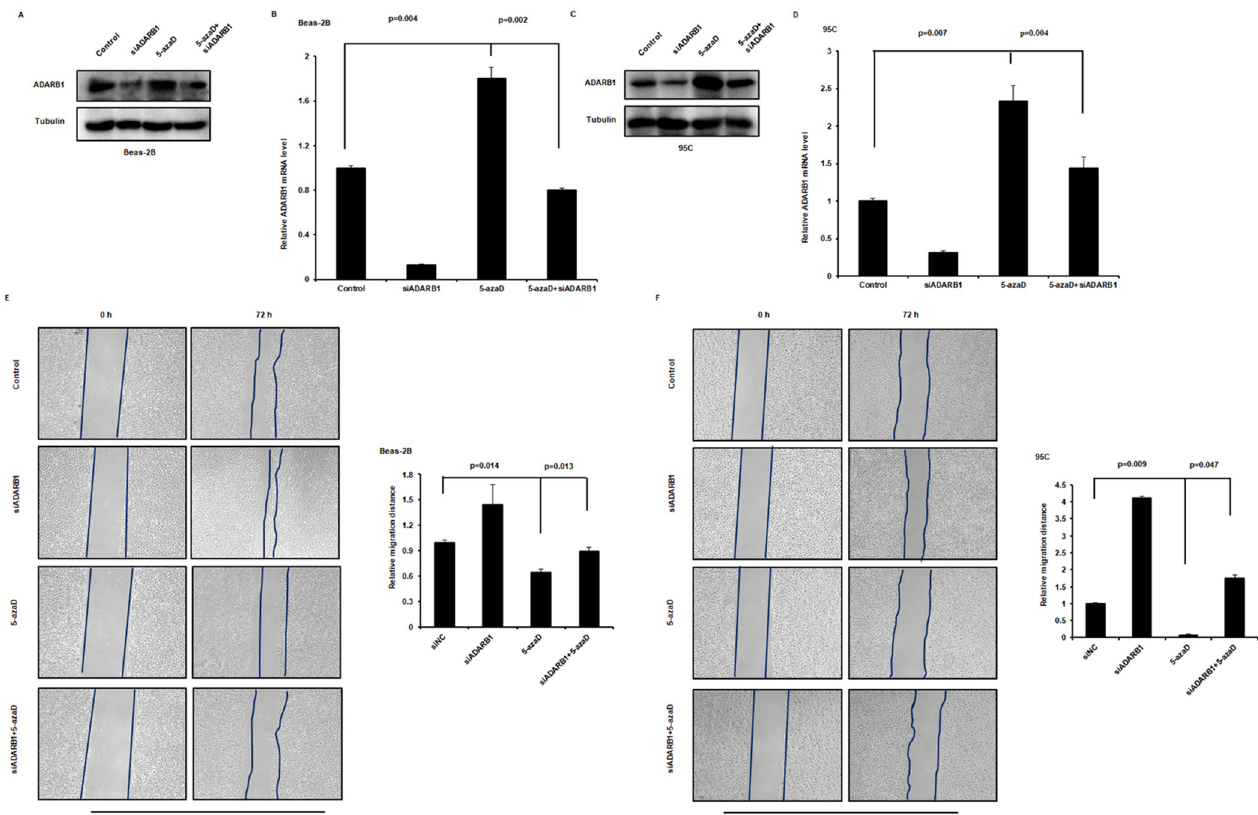
Fig 6. Modulation of DNA methylation inhibited ADARB1-reduced LUAD cell metastasis. Beas-2B (A, B) and 95C cells (C, D) treated with siADARB1 and/or DNMT inhibitors 5-azaD subjected to Western blot and RT-PCR assays. The wound healing assays were performed after treating Beas-2B (E) and 95C (F) cells with siADARB1 and/or DNMT inhibitors